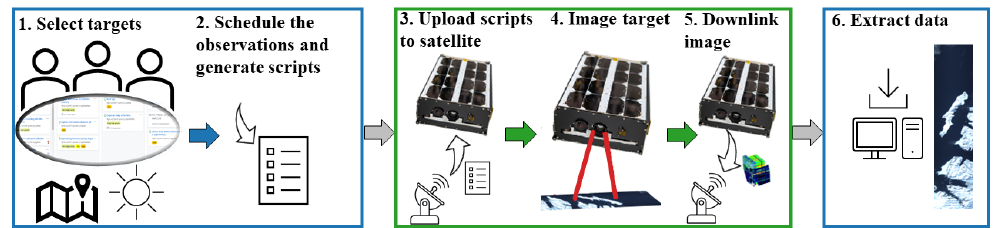
Figure 2. Overview of the imaging process. The planning parameters can be seen in Table 2. The blue boxes indicate human interactions. Currently, an automated pipeline is developed for data extraction. The green box indicates automated processes by the MCS and the satellite